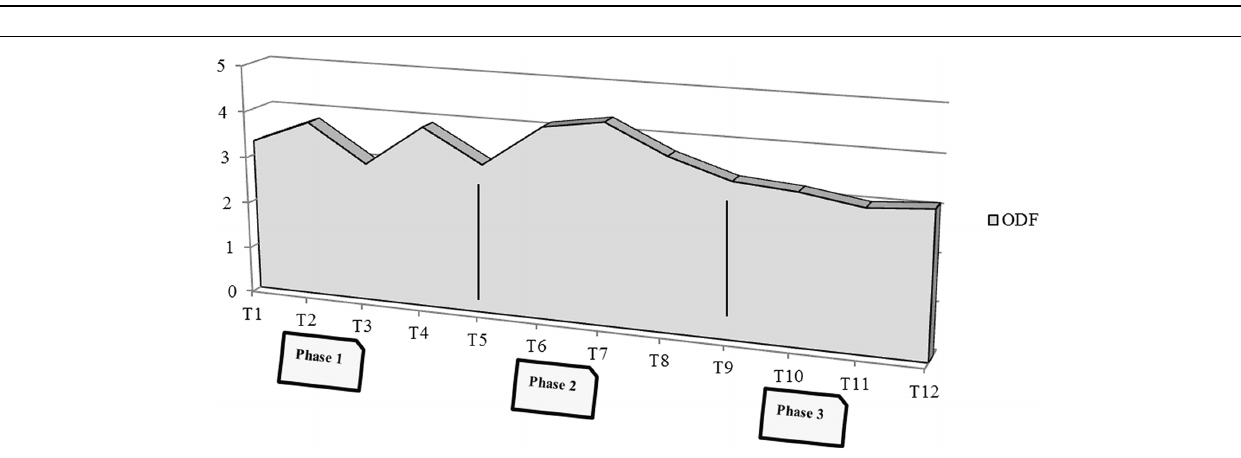
FIGURE 2 | Mr. F’s DMRS: course of the global scores of the defenses during the therapy (monthly acquisition).